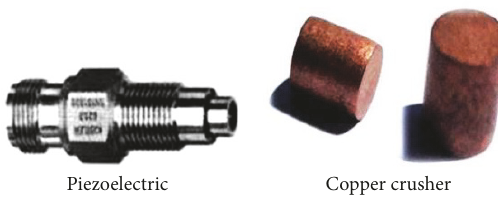
Figure 1: Piezoelectric sensor and copper